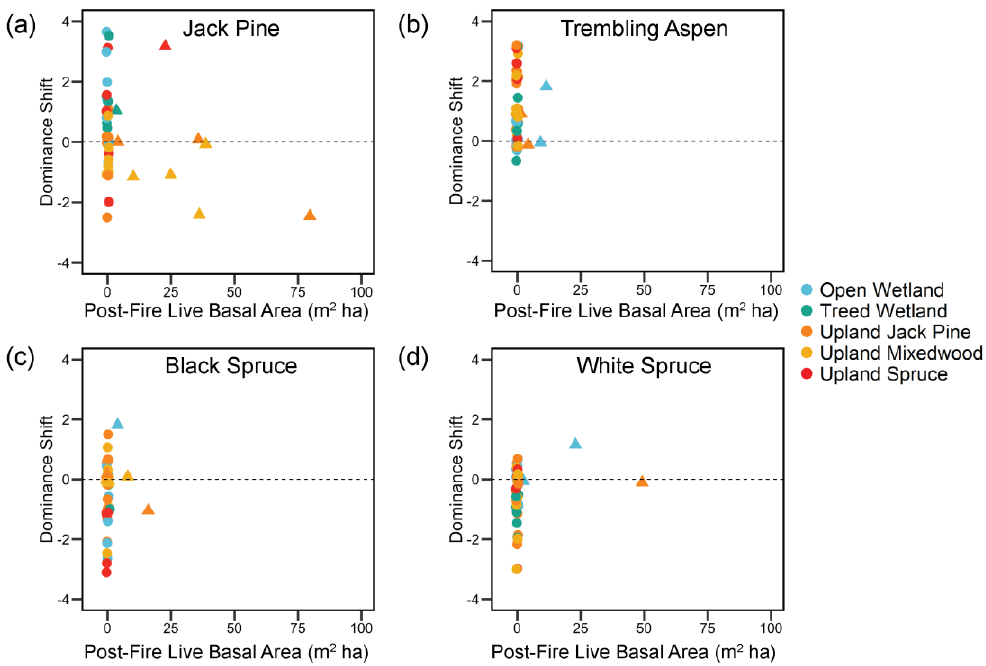
Figure 3. Increases and decreases in the post-fire dominance of ( a ) jack pine; ( b ) trembling aspen; ( c ) black spruce; and ( d ) white spruce, plotted against the post-fire live basal area of the same species. Points are coloured by topoedaphic vegetation classes. Circles indicate sites where the species experienced complete mortality or was absent pre-fire. Triangles indicate sites that had live residual basal areas of the species of interest following a wildfire. Points are offset (“jittered”) to reduce overlap. Dashed horizontal lines indicate no change in species dominance post-fire. Points above this line increased in dominance post-fire, and points below are those sites that experienced a decline of the species of interest in the post-fire cohort.